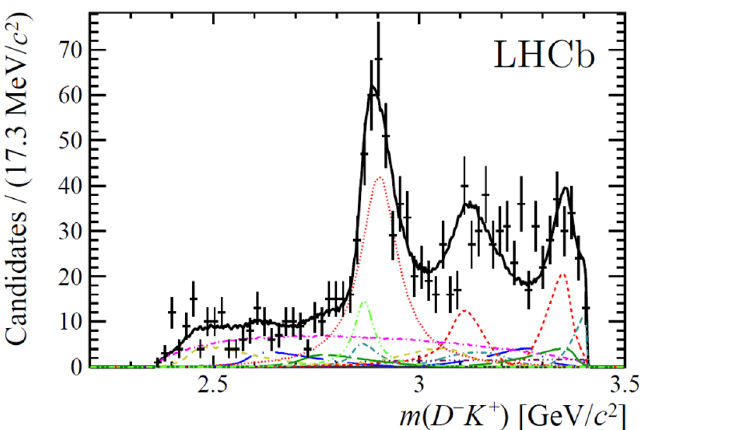
Figure 1 . Distribution over the invariant mass of D − K + in the decay B + → D + D − K + in the LHCb [1] data. The dots show the data, the curves show the resulting fit function and the contributions of the individual components of the model.